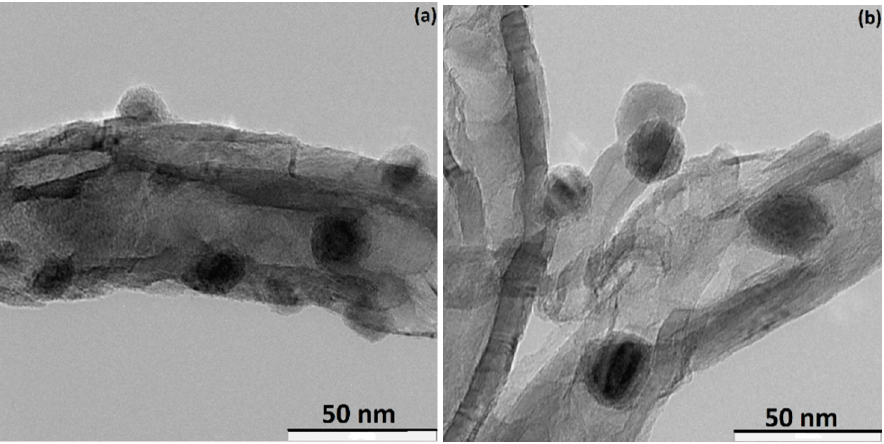
Figure 2. TEM image of the catalyst after FTS with thermal treatment ( a ) 600 °C ( b ) 900 °C.